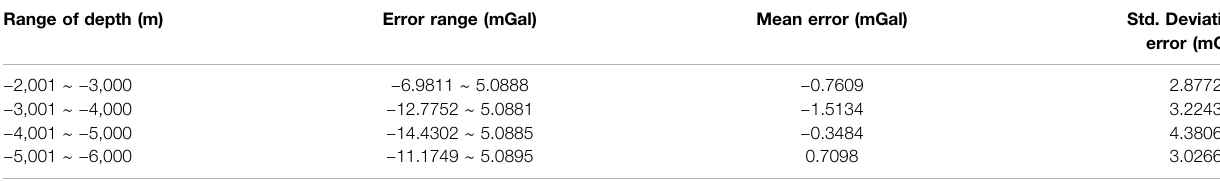
TABLE 7 | Improved accuracy assessment of modelled gravity anomalies with respect to change in ocean depth. Range of depth (m) Mean error (mGal) Std. Deviation of